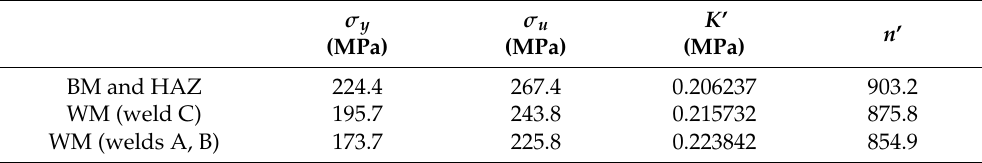
Table 4. Cyclic R-O parameters.